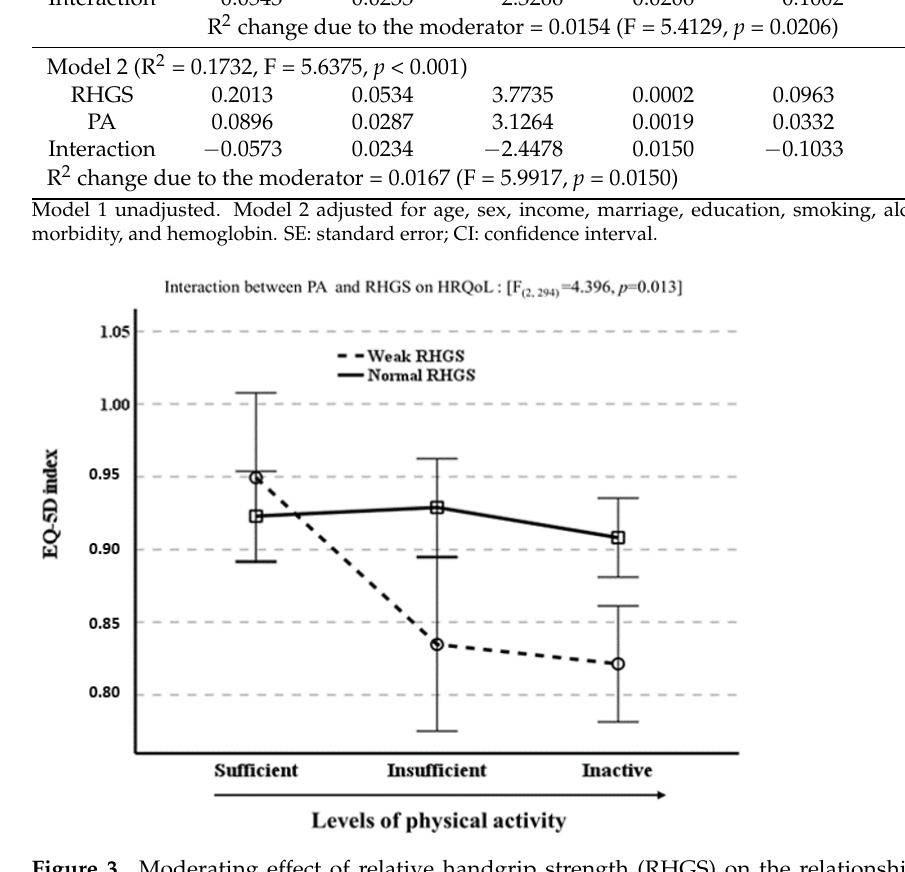
Figure 3. Moderating effect of relative handgrip strength (RHGS) on the relationship between physical activity (PA) and health-related quality of life (HRQoL). Physical activity was classified as sufficient ( ≥ 600 METs-minute/week) or insufficient (1~<600 METs-minutes/week) or inactive (sedentary or no physical activity).